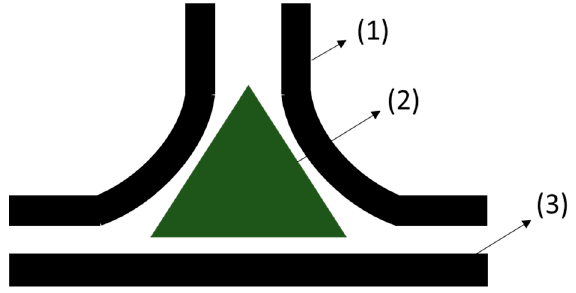
Figure 7. 2D view of the components of a T-joint assembly, webs (1), deltoid (2) and platform (3).